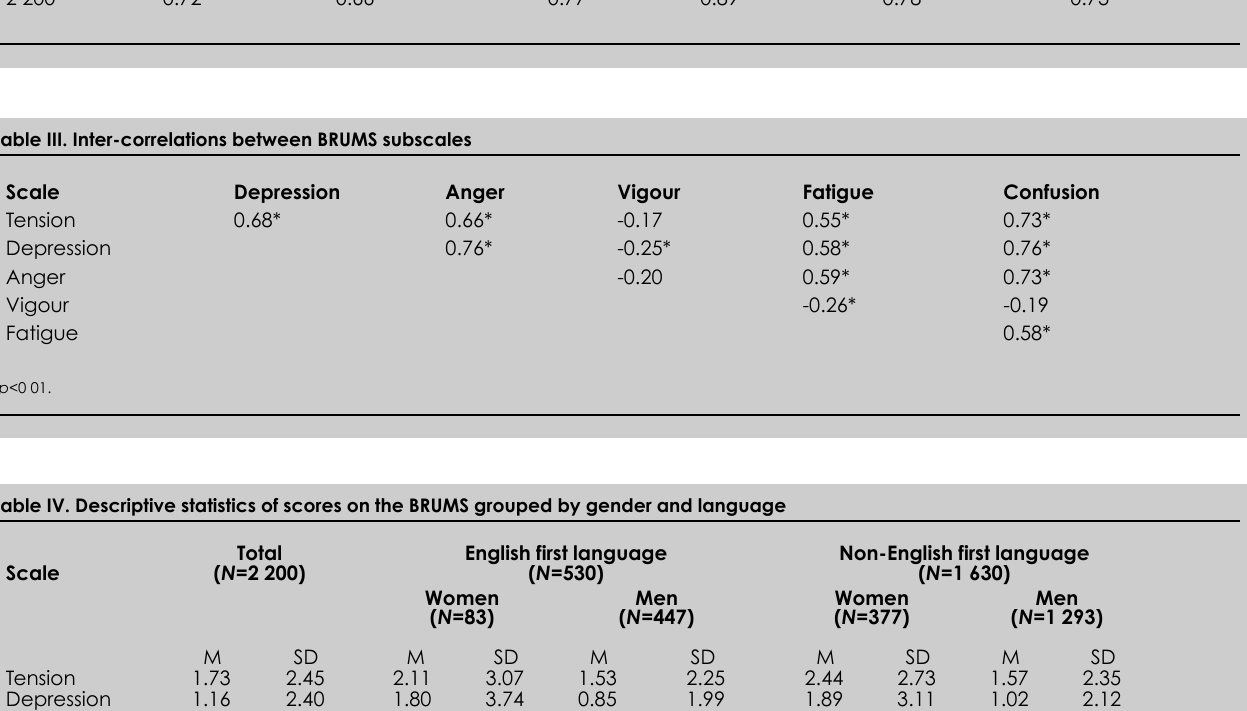
Table II. Alpha coefficients of the BRUMS subscales N